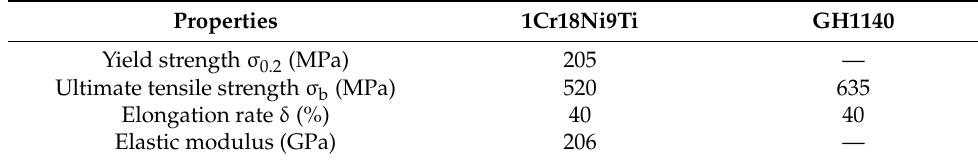
Table 2. Mechanical properties of 1Cr18Ni9Ti stainless steel and GH1140 Ni-based